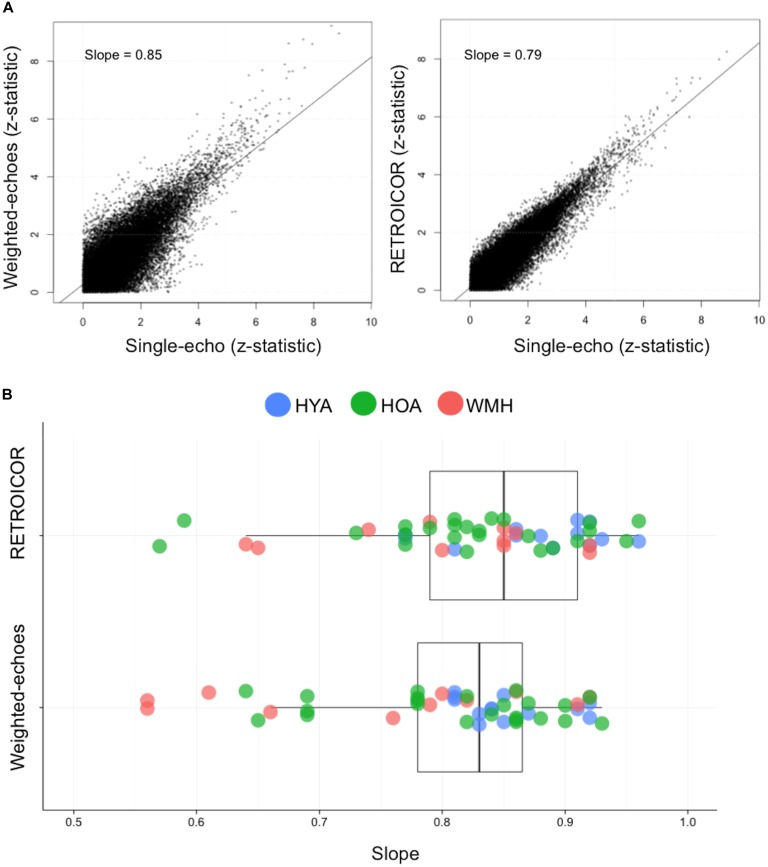
Relationship between single-echo functional image acquisition with RETROICOR and weighted-echoes post-processing methods. (A) The comparison between single-echo acquisition and functional image with RETROICOR data or weighted-echoes technique using z-stats from each voxel from a representative individual. The coefficient of determination was lower for weighted-echoes (P < 0.001), which demonstrates RETROICOR had more shared variance with single-echo processing method. (B) The slope of RETROICOR versus single-echo and the slope of weighted-echoes versus single-echo were both less than one (P < 0.001), indicating single-echo acquisition z-stats were relatively greater than after RETROICOR or weighted-echoes processing was applied. The two sets of slope estimates were not significantly different (P = 0.1).